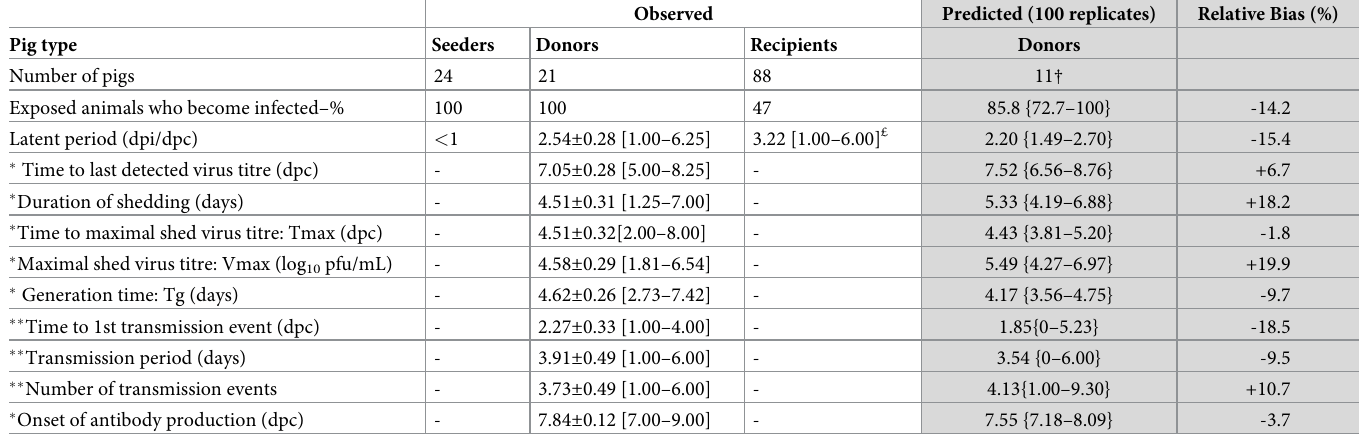
Table 1. Viral kinetics and transmission events description and predicted from viral kinetic model coupled to the Bayesian logistic regression prediction. For quan- titative variables: mean ± se [range], for qualitative variables: number or percentage. Dpi stands for days post inoculation and dpc for days post contact. Predictions: 100